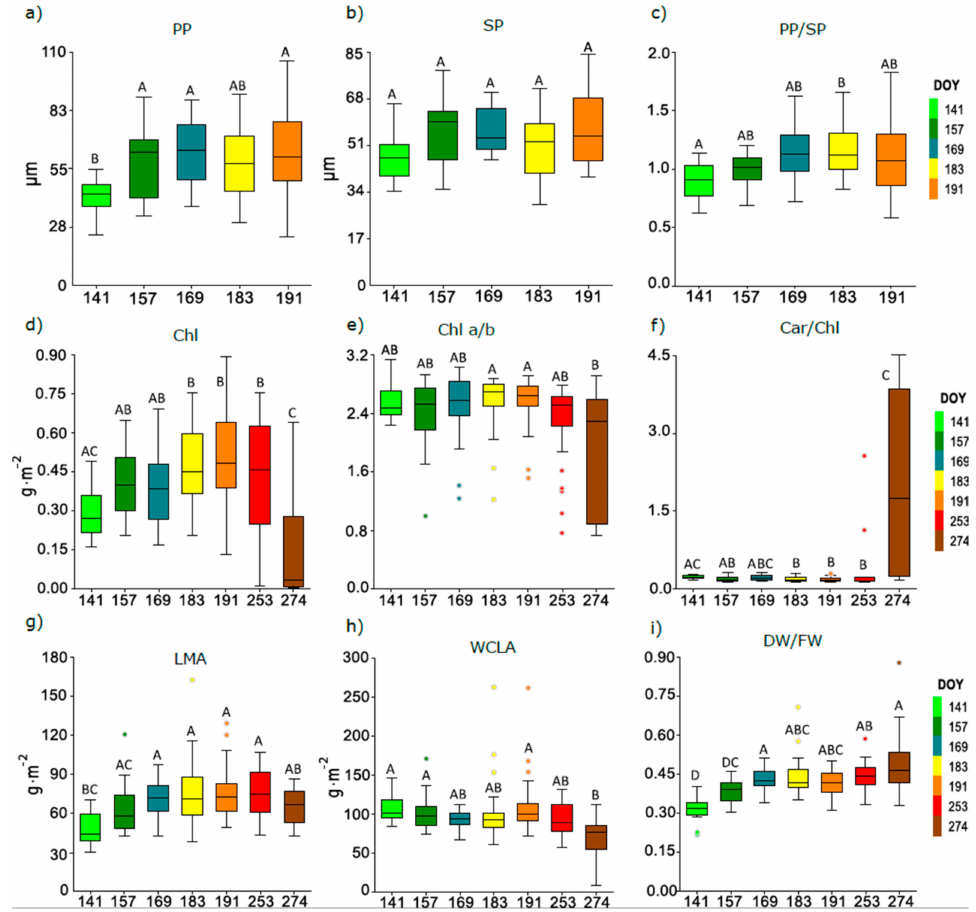
Figure 5. The mean values of biophysical and anatomical traits during the season (DOYs: 141, 157, 169, 183, 191, 253, and 274). Data were pooled for all species ( B. pendula , A. incana , P. tremula ) independently on leaf developmental category (juvenile, mature, and senescent leaves). ( a ) PP: palisade parenchyma thickness; ( b ) SP: spongy parenchyma thickness; ( c ) PP/SP: palisade/spongy parenchyma thickness ratio; (the analysis for DOYs 253, 274 were not performed for a–c); ( d ) Chl: chlorophyll a + b content; ( e ) Chl a/b: chlorophyll a/b ratio; ( f ) Car/Chl: carotenoids/chlorophyll ratio; ( g ) LMA: leaf mass per area; ( h ) WCLA: water content per leaf area; ( i ) DW/FW: dry/fresh weight ratio. Difference among the values for different DOYs in one group was tested by the analysis of variance, α = 0.05. Different colors correspond to individual DOYs during the season; line in boxes corresponds to the median value, error bars show inter-quartile range (IQR); dots correspond to outliers defined as three times IQR; same letters above boxes indicate no significance, different letters correspond to significant difference among DOYs within one graph at α =